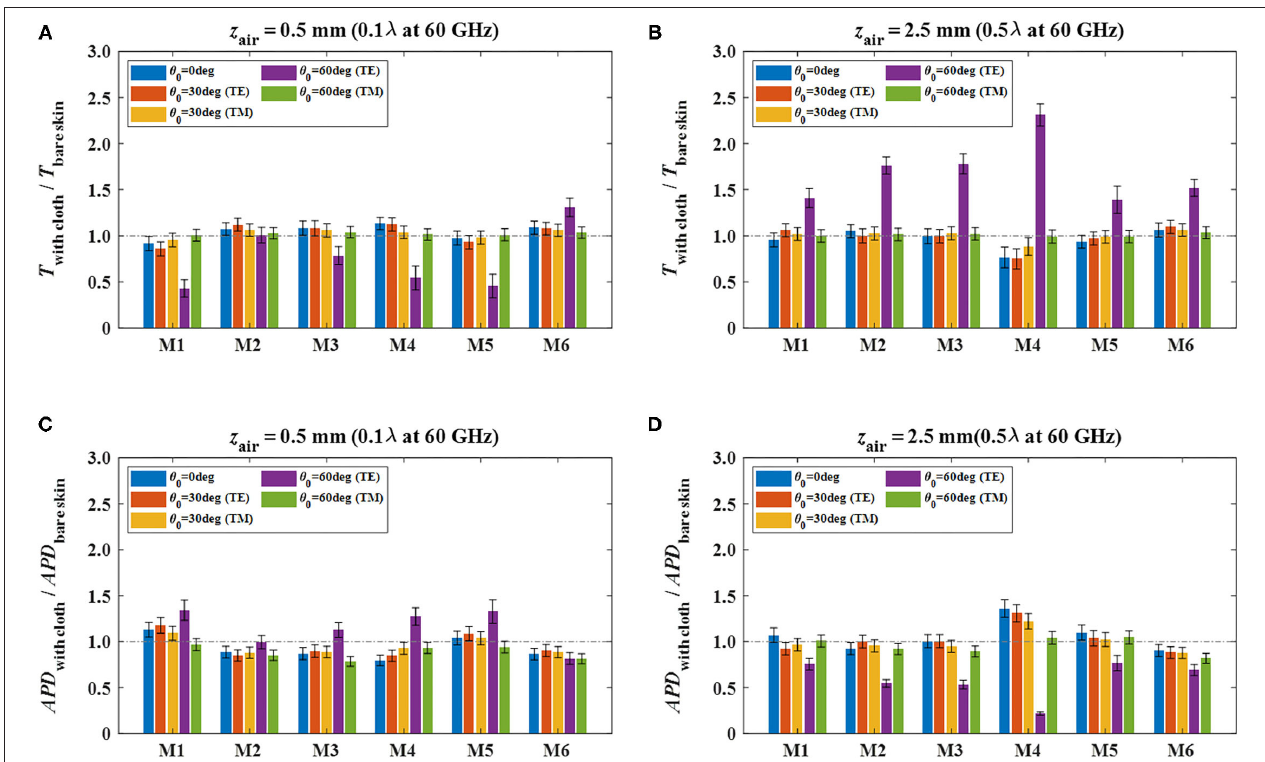
FIGURE 3 | Ratios of transmittance and absorbed power density at skin surface with various cloth materials to those of bare skin at different air gap spacing, (A) T with cloth / T bare skin ( z air = 0.5mm), (B) T with cloth / T bare skin ( z air = 2.5mm), (C) APD with cloth / APD bare skin ( z air = 0.5mm), and (D) APD with cloth / APD bare skin ( z air =